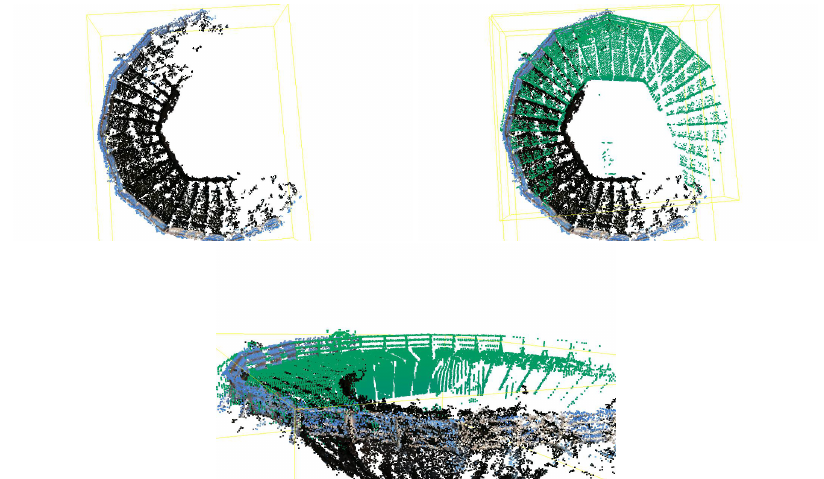
Figure 3: Left; balcony of the windmill from the smartphone point cloud. Middle and right; after fine alignment process on the laser scanning point cloud.